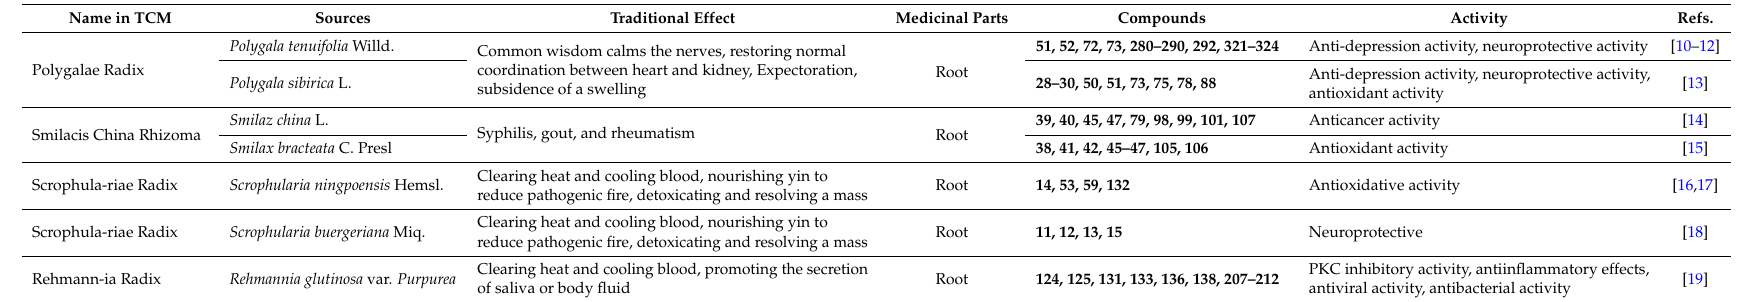
Table 2. The Principal Compounds of CASEDs Distributed in TCMs.